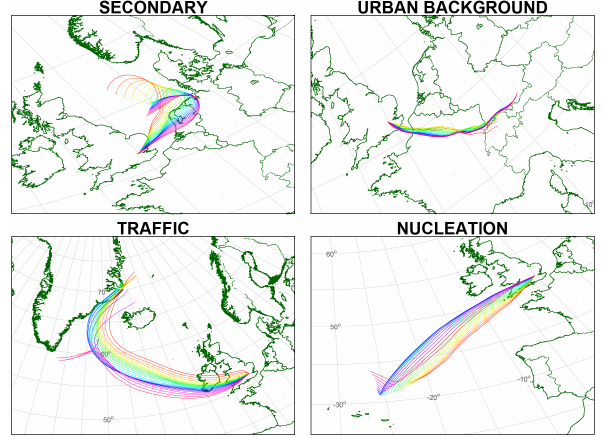
Figure 10. Clustered 5-day back trajectories from Met Of- fice (2012) arriving daily at midday at North Kensington over the sampling